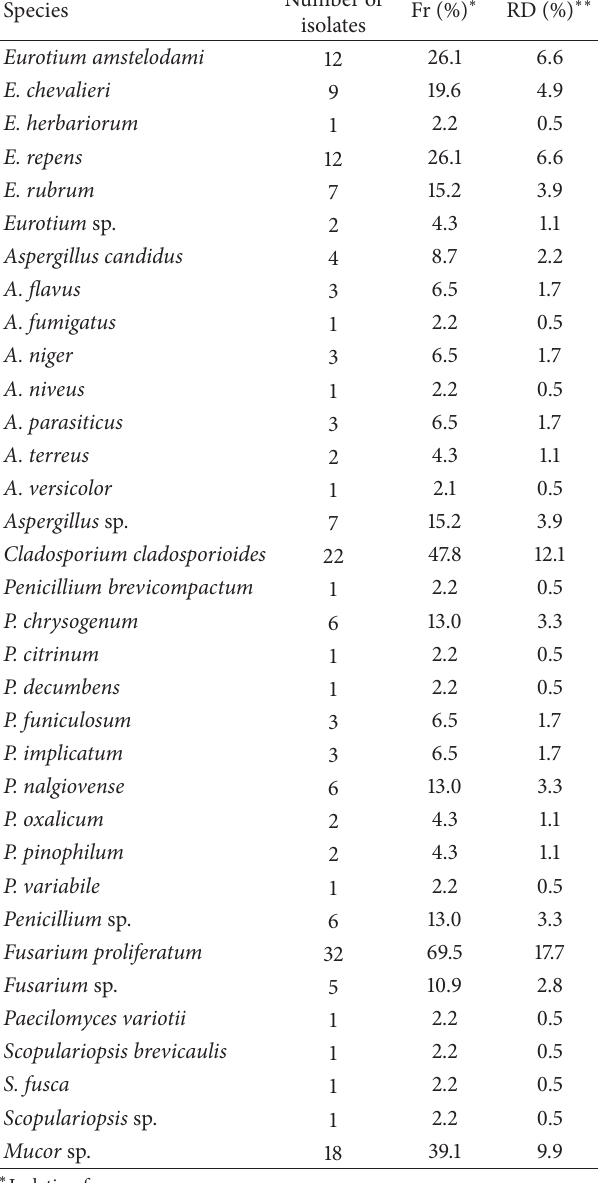
Table 3: Fungal species present in poultry feed samples. Species